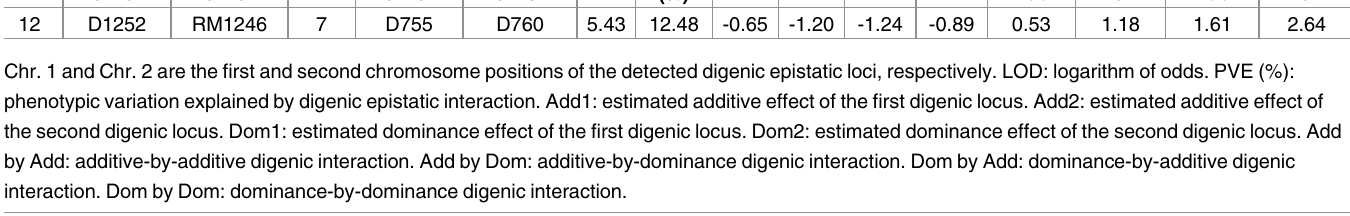
fixes in QTL names indicate the allele was inherited from the ‘Lemont’ or the ‘Yangdao 4’ par- ent, respectively. A linear regression analysis was performed to examine if the 12 alleles in the six QTLs acted additively across loci leading to a linear relationship between the predicted breeding values of QTLs and the phenotype. Such a linear relationship implies that plants carrying more grain- weight-increasing alleles have heavier grains than those carrying more grain-weight-decreas- ing alleles. We first calculated the genotypic value of each individual plant (or line) in the seven mapping populations, which was used as the predictive breeding value of each individual plant or line. The genotypic value of an individual plant or line was calculated by adding the Table 5. The pair of digenic epistatic loci detected in the F 2 population, derived from ‘Lemont’ × ‘Yangdao 4’ and grown in 2012 in Hangzhou, using inclusive composite interval mapping. Chr.1 Left Right Chr.2 Marker 1 Marker 1